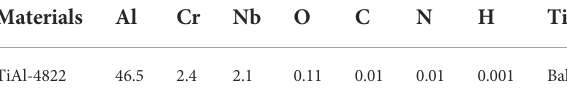
TABLE 1 Chemical compositions of TiAl-4822 and 316 stainless steel